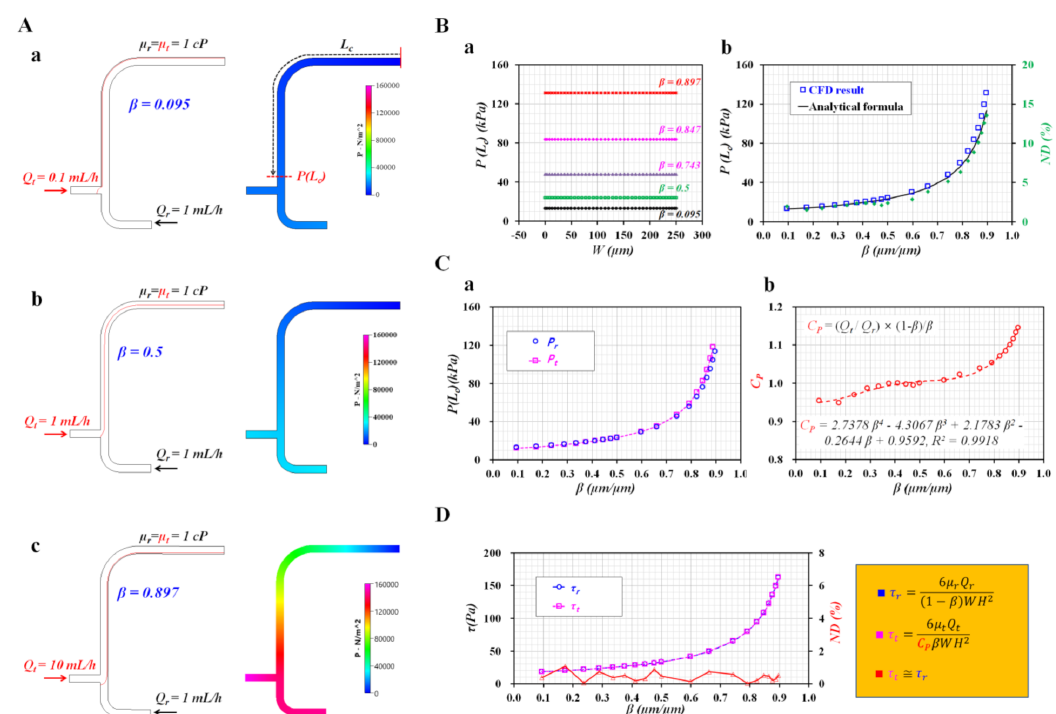
Figure 2. Quantitative validation of pressure and shear stress. ( A ) Distribution of pressure and interface obtained with CFD simulation results with respect to flow rate of test fluid. The flow rate of the reference fluid was fixed at Q r = 1 mL/h. Both fluids had the same viscosity (i.e., µ r = µ t = 1 cP). The corresponding interface for each flow rate of test fluid was obtained at (a) β = 0.095 for Q t = 0.1 mL/h, (b) β = 0.5 for Q t = 1 mL/h, and (c) β = 0.897 for Q t = 10 mL/h. The right-side panel showed distributions of pressure along the coflowing channel with respect to Q t . ( B ) Quantitative comparison of pressure between CFD simulation and analytical formula. (a) Variations of pressure obtained with CFD simulation with respect to β = 0.095, 0.5, 0.743, 0.847, and 0.897. (b) Variations of pressure obtained with both methods and ND (normalized difference) between two pressures with respect to interface ( β ). ( C ) Correction factor ( C P ) for correcting the same pressure of both streams in the coflowing channel. (a) Variations of the pressure of P r and P t with respect to β . (b) Variations of a correction factor of pressure ( C P ) with respect to β . Based on C P = ( Q t / Q r ) × (1 − β )/ β , the C P was obtained as C P = 2.7378 β 4 − 4.3067 β 3 + 2.1783 β 2 − 0.2644 β + 0.9592 ( R 2 = 0.9918). ( D ) Variations of shear stress of τ r and τ t and ND between two shear stresses with respect to β . The right-side panel showed shear stress expression for each